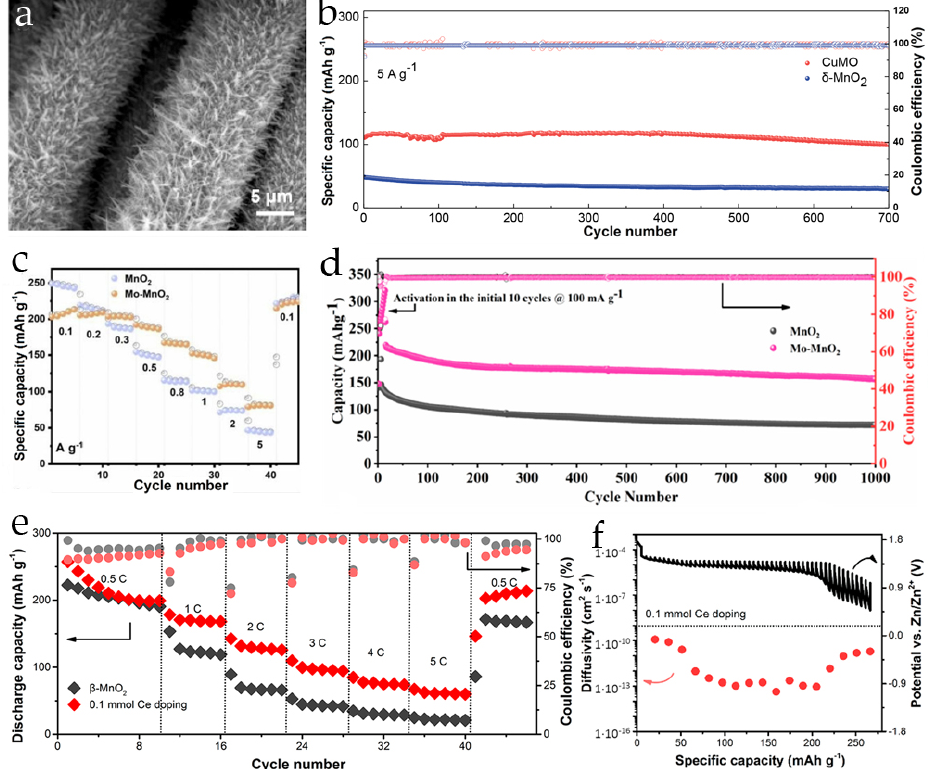
Figure 7. ( a ) SEM image of CuMO [48]. ( b ) Cycling performance of MnO 2 and CuMO electrodes at 5 A·g − 1 [48]. ( c ) Rate performance of MnO 2 and Mo-MnO 2 cathodes [51]. ( d ) Cycling performance of MnO 2 and Mo-MnO 2 cathodes [52]. ( e ) Rate capability of Ce-doped MnO 2 [54]. ( f ) GITT curve and diffusivity vs. state of discharge for Ce-doped MnO 2